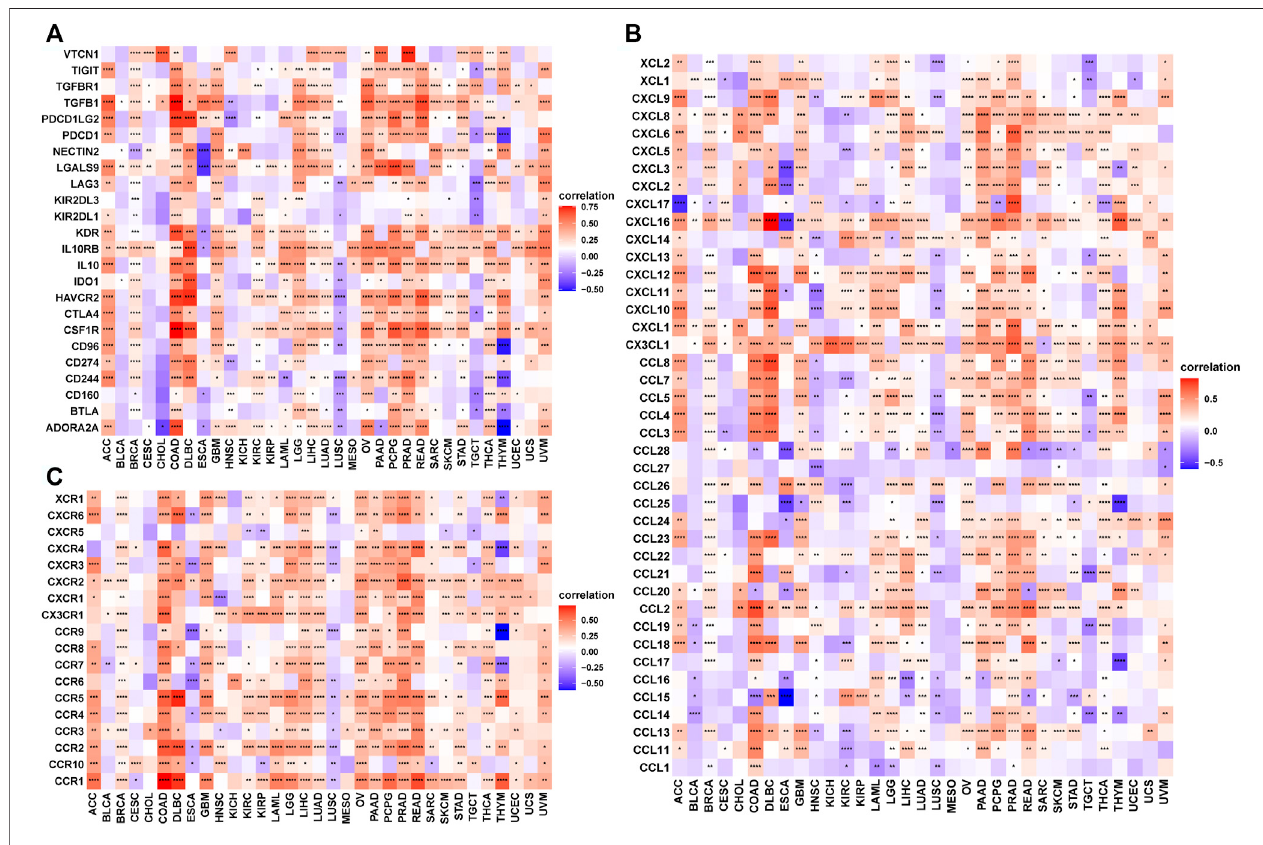
FIGURE 7 | The correlation between TRPV4 and immunosuppressive genes. (A) Heatmap representing the correlation between TRPV4 expression and immunosuppressive status-related genes. (B) Heatmap representing the correlation between TRPV4 expression and chemokine genes. (C) Heatmap representing the correlation between TRPV4 expression and chemokine receptor genes. The pearson ’ s correlation coef fi cient was calculated using R